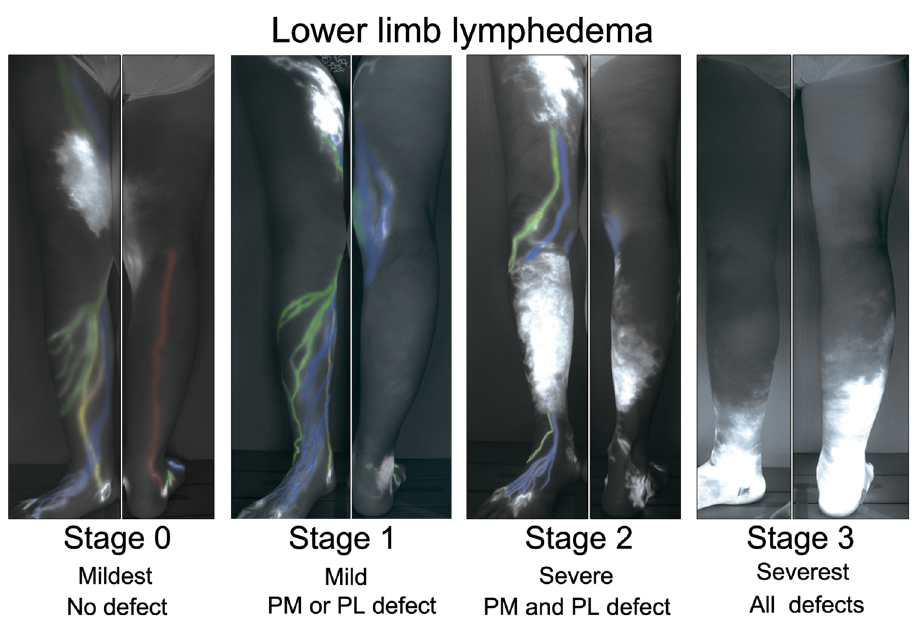
Figure 6. LPad (lymphatic pathways defects) severity classification of lower limb lymphedema. Indocyanine green lymphographic images of four lymphedema legs show the four-colored lymphatic vessel groups and dermal back-flow: anteromedial (blue), anterolateral (green), posteromedial (yellow), and posterolateral (red). Double defects of the posteromedial and posterolateral groups were more severe than a single defect of these two groups. Defects of all lymphatic groups, including the anteromedial and anterolateral groups, were more severe than double defects; previous reports have shown that in the terminal stage of leg lymphedema, all lymphatic collecting vessels in the legs are